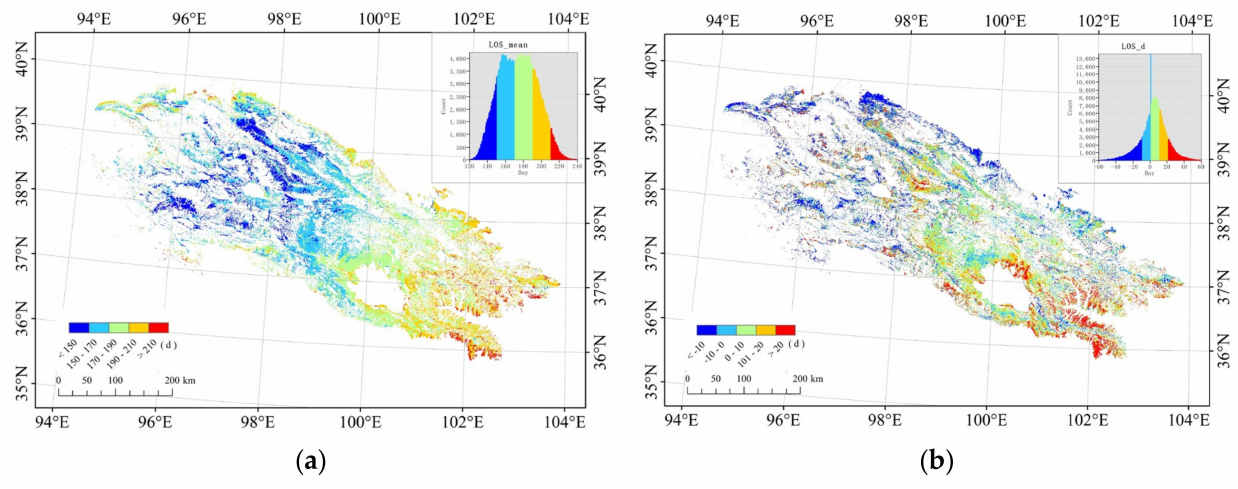
Figure 10. Spatial distribution of ( a ) average LOS for 20 years from 2000 to 2019 and ( b ) difference in LOS for 20 years by linear regression from 2000 to